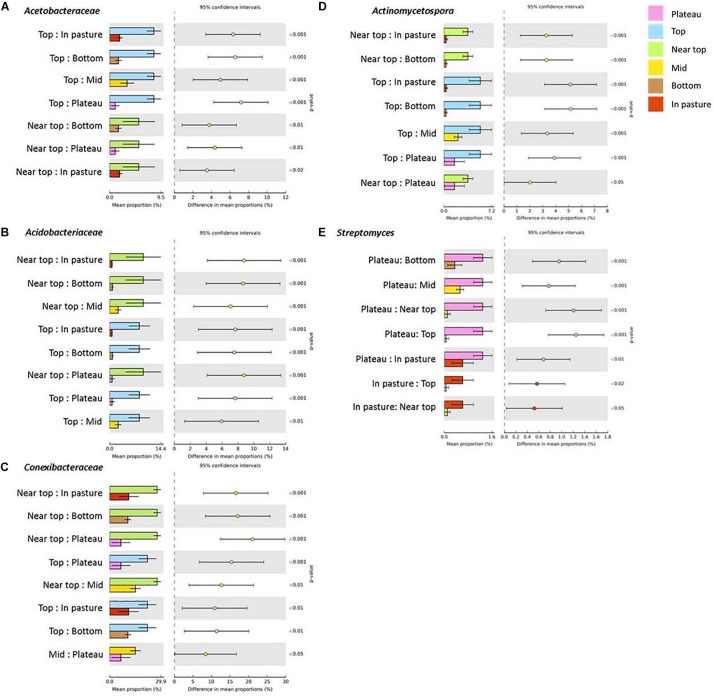
Bacterial taxa with significantly higher mean abundances in the upper (near top and top, A–D) and plateau (E) sections of T210 relative to all other sections of this transect (Benjamini–Hochberg FDR P < 0.05, difference in mean proportion > 2%).